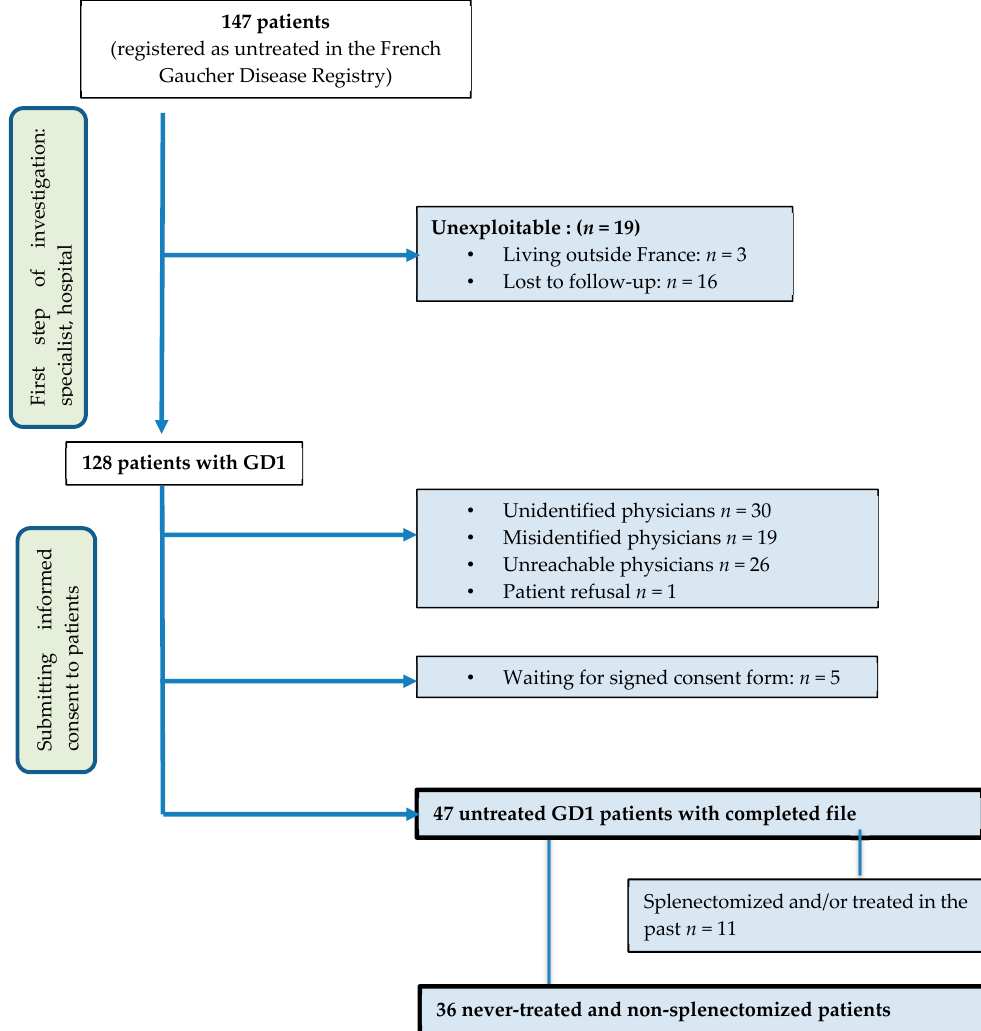
Figure 1. Patients’ inclusion flowchart. GD1: type 1 Gaucher disease. Table 1. Patients’ characteristics.